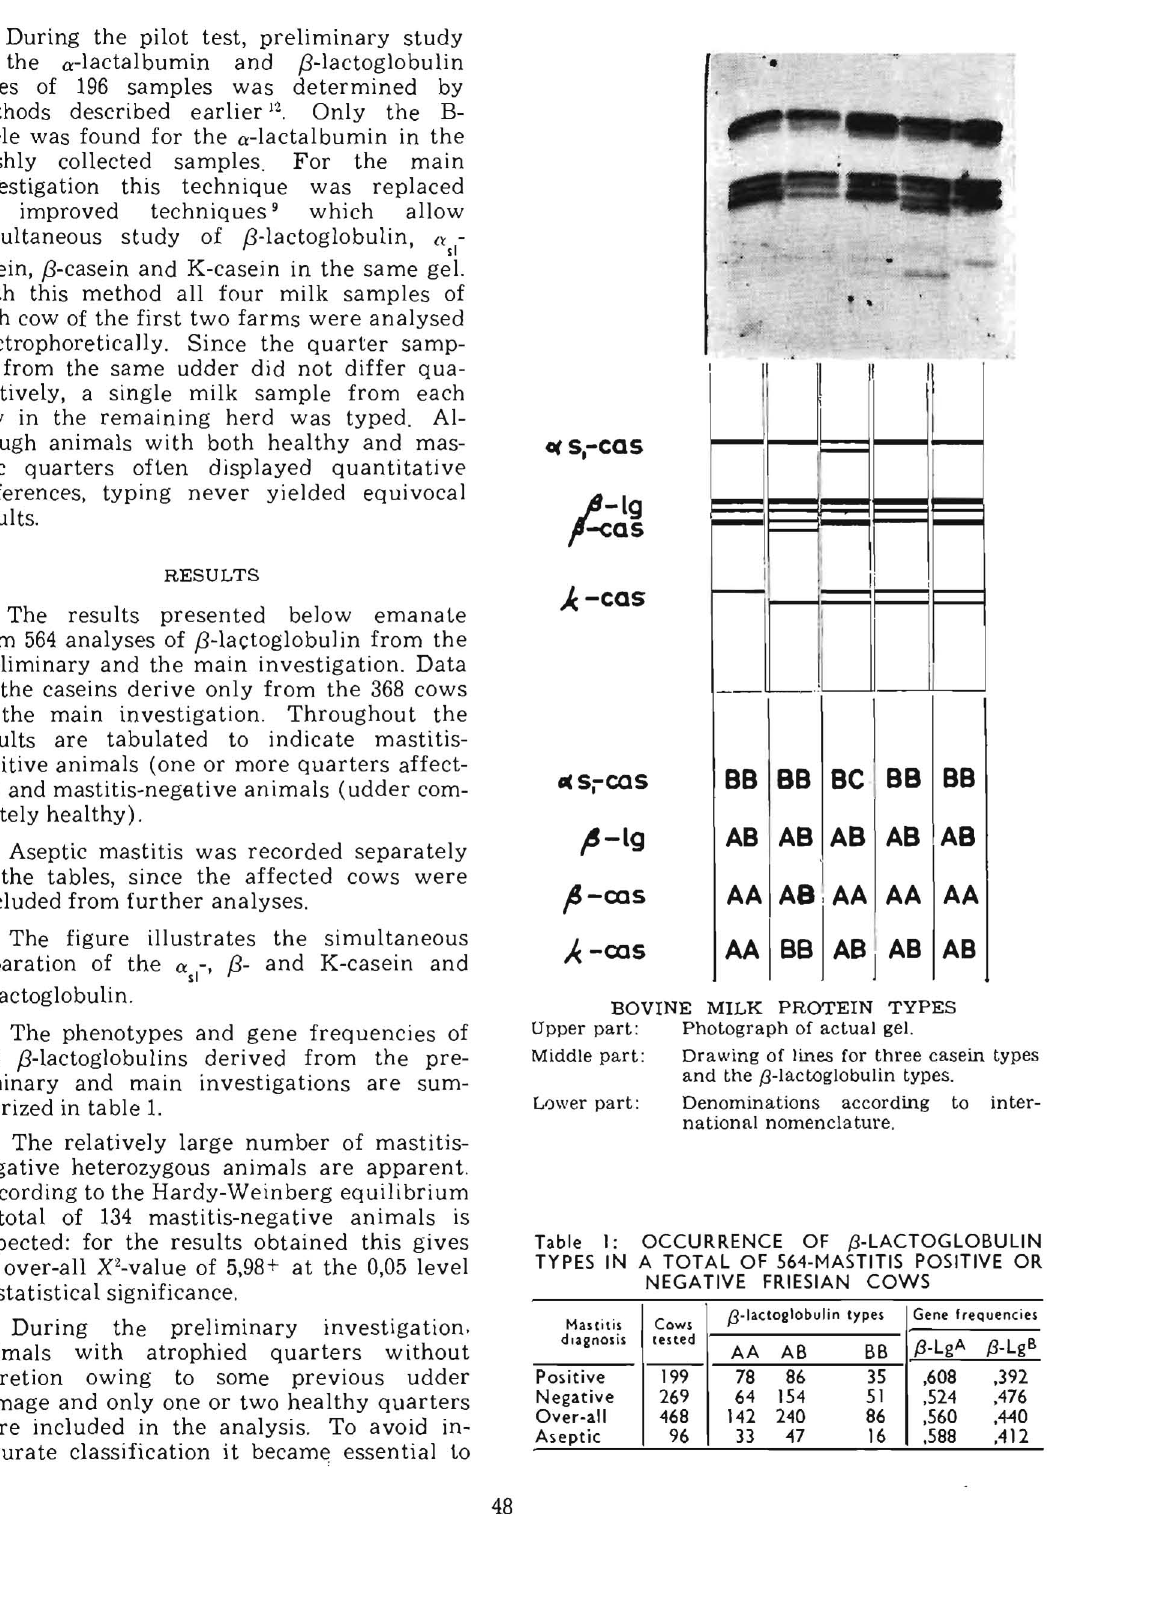
Table 1: OCCURRENCE OF ,6-LACTOGLOBULIN TYPES IN A TOTAL OF 564-MASTlTlS POSITIVE